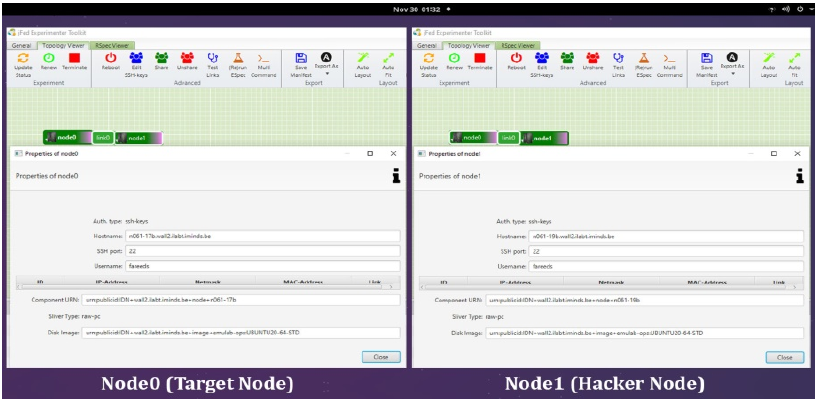
Figure 9. Visual depiction of the test device, the control device, and the reference device mounted Figure 10. JFed layout of the user interfaces of the test device and the control device mounted on on Node0 (target node) . Node0 (target node) .